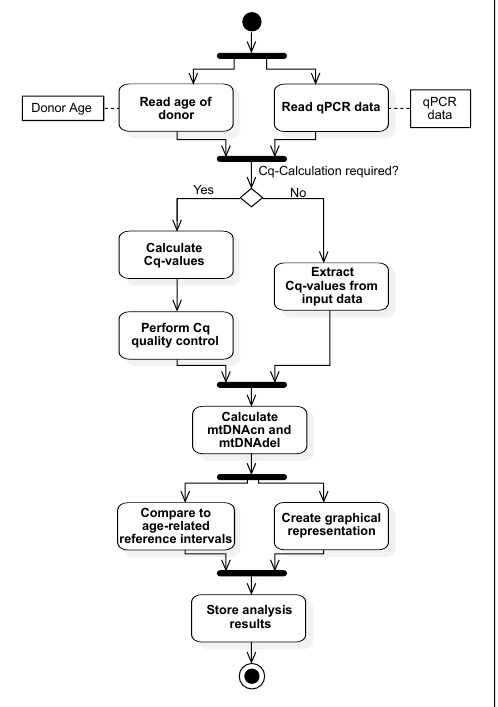
Figure 2. Activity diagram of the mtDNA analysis